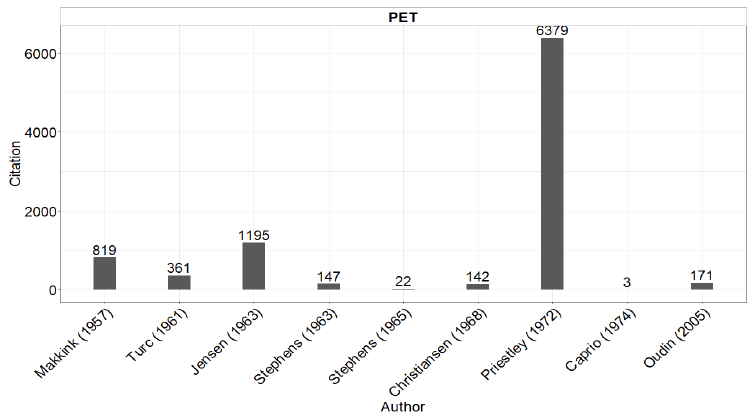
Figure 4. Citations of PET radiation-based equations.